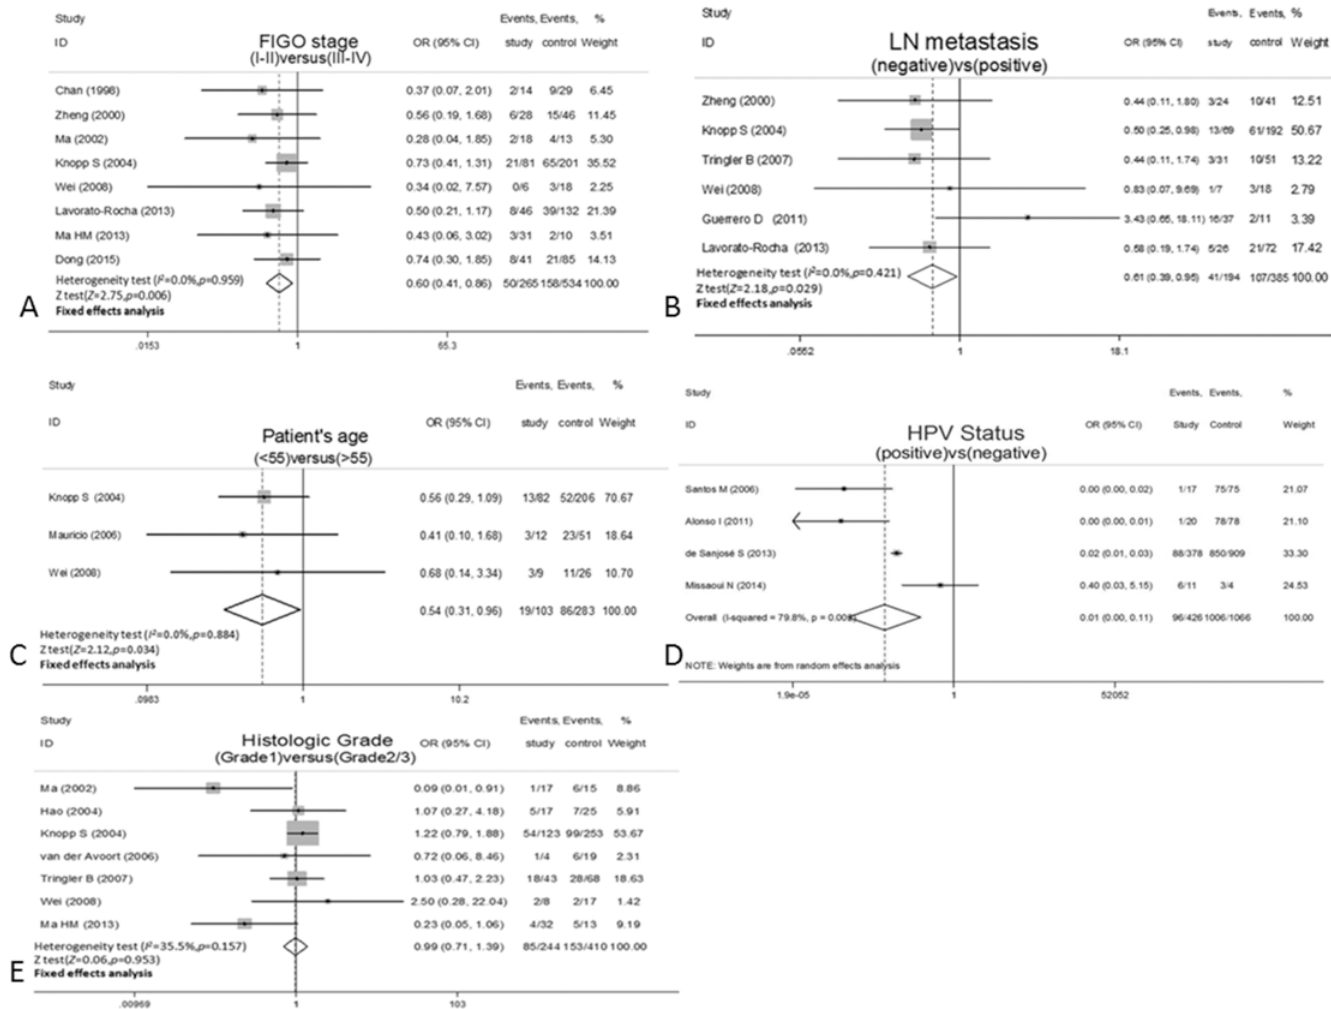
Fig 2. Forest plot for the association between p16INK4a expression and clinicopathological markers (A) FIGO stage.(B) LN metastasis. (C) Patient's age. (D) HPV status. (E) Histological grade. FIGO, International Federation of Gynecology and Obstetrics; LN, lymph node; HPV, human papillomavirus.